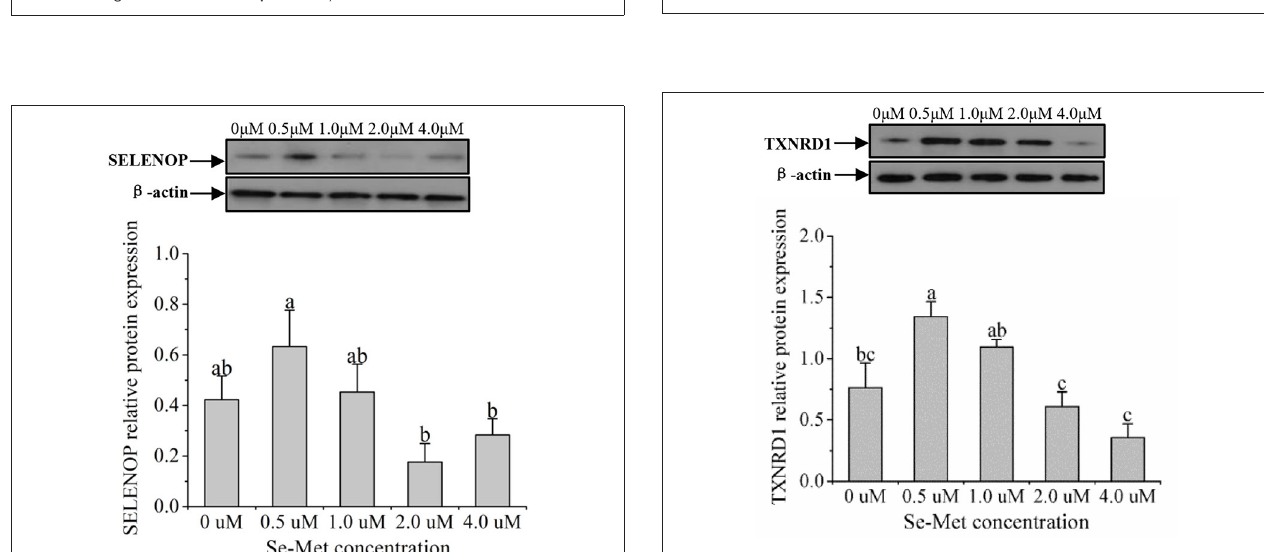
FIGURE 4 | Effects of selenomethionine (Se-Met) supplementation on SEPHS2 protein expression in porcine mammary epithelial cells (pMECs). The cells were incubated for 48h with different concentrations of Se-Met (0, 0.5, 1, 2, and 4 µ M), and then collected for determination of protein expression. The data are expressed as the mean ± SEM ( n = 3). Different superscript letters indicate a significant difference ( p < 0.05).